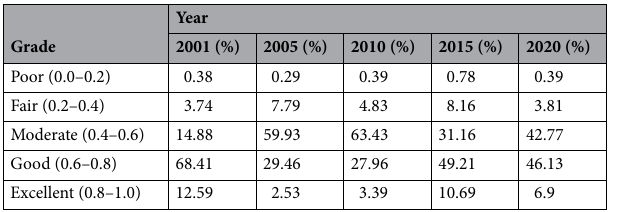
Year 2001 (%) 2005 (%) 2010 (%) 2015 (%) 2020 (%)